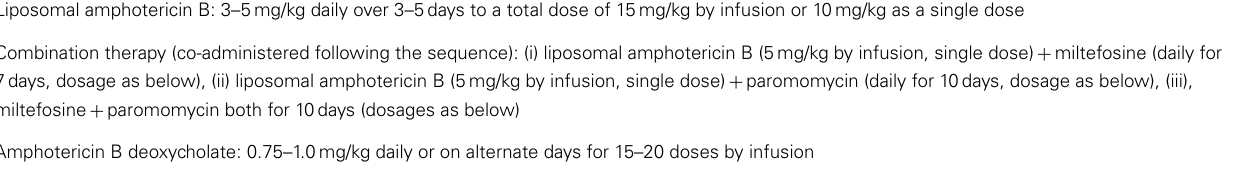
Table 1 | Recommendations of theWorld Health Organization for the treatment of visceral leishmaniasis per geographic region ranked by preference [World Health Organization (59)] .